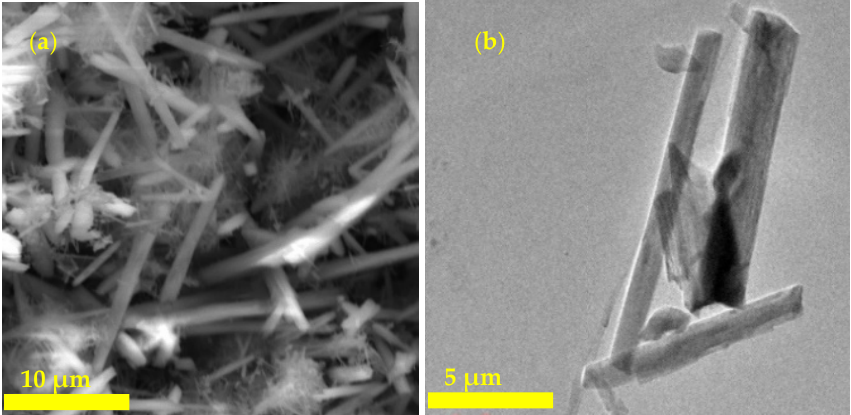
Figure 4. SEM ( a ) and TEM ( b ) micrographs of ZSM‐22 zeolite material hydrothermally synthesised using tetraethyl orthosilicate (TEOS) source at Si/Al 60.